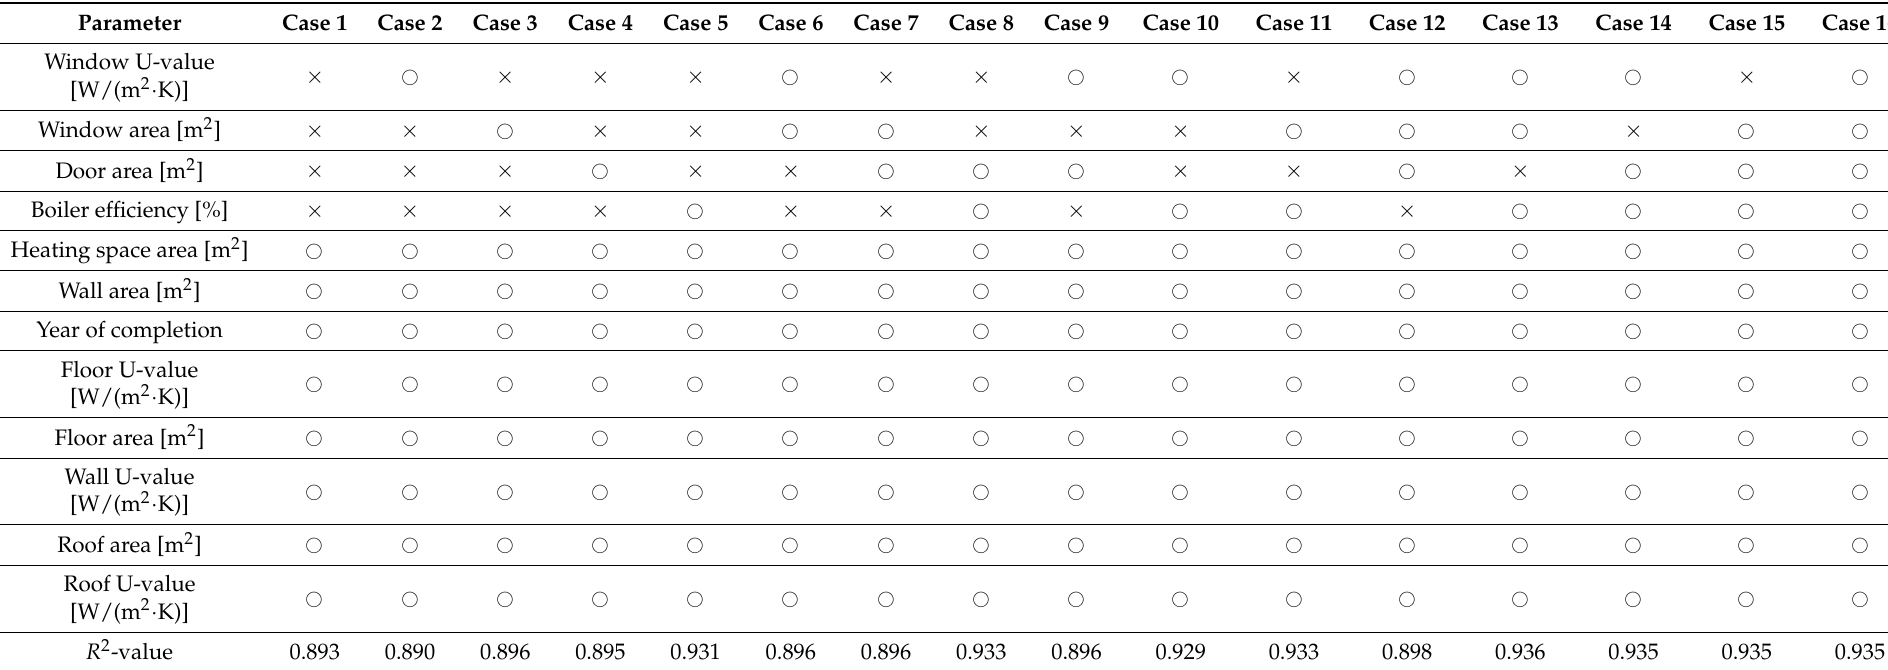
Table 5. Cases of available combinations of the input variables selected from the SPSS correlation analysis and performance results ( R 2 -values) for each case predicted from the initial DNN